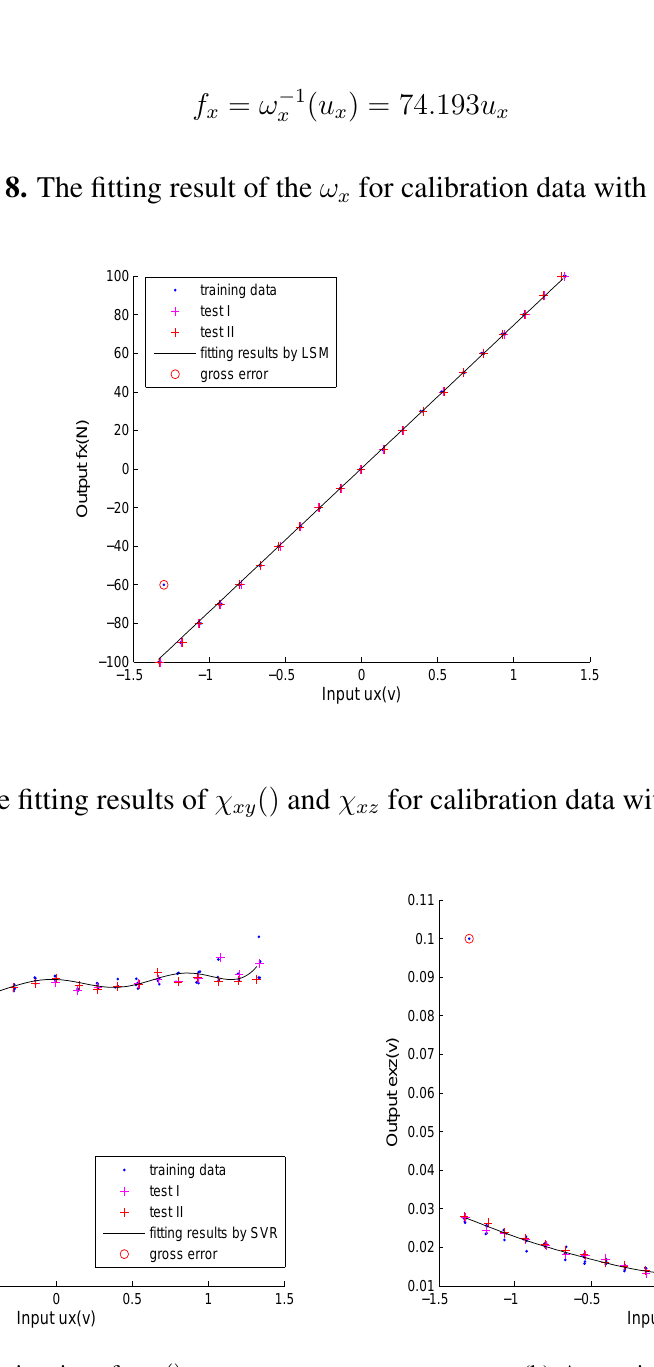
(b) Approximation of χ xz